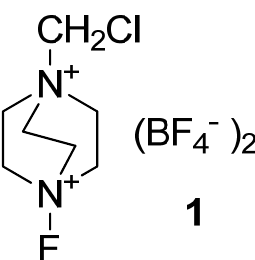
Figure 1. 1-Chloromethyl-4-fluoro-1,4-diazoniabyciclo[2.2.2]octane bis(tetrafluoroborate) Selectfluor F-TEDA-BF 4